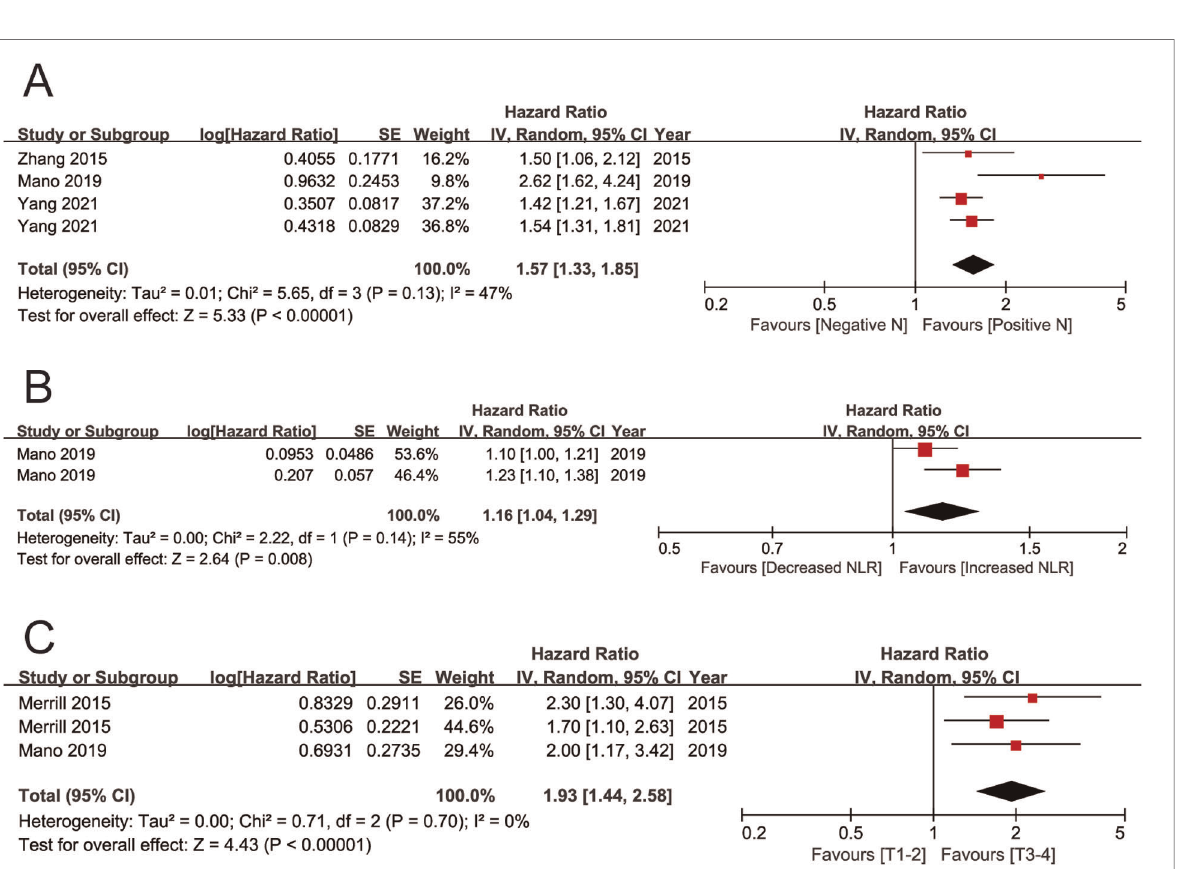
FIGURE 4 Forrest plots of meta-analyses of predictors of cancer-speci fi c survival and progression-free survival: ( A ) positive lymph node; ( B ) NLR; ( C ) T stage (3 – 4 vs 1 – 2). NLR, neutrophil to lymphocyte